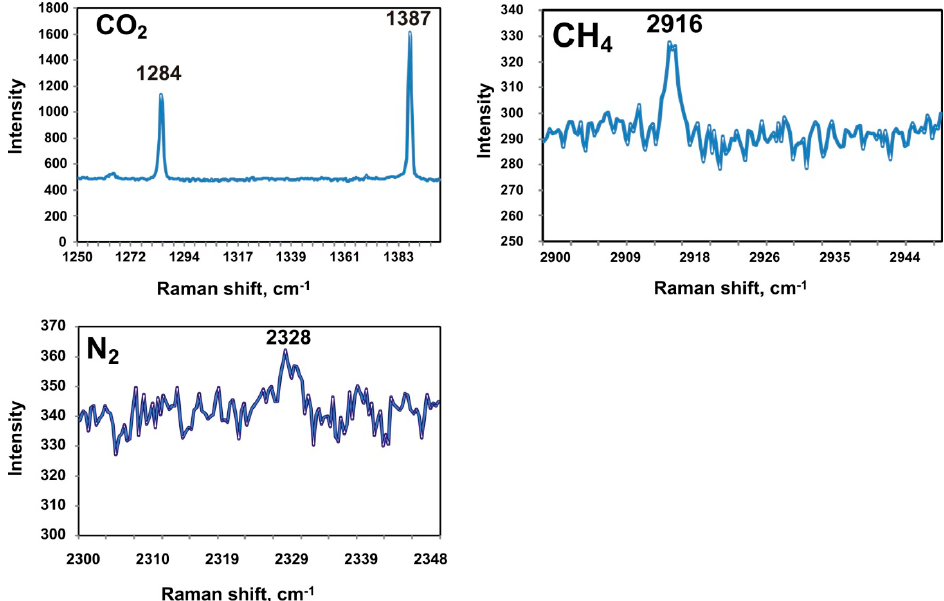
Figure 10. Results of Raman spectroscopy of individual primary fluid inclusions. Table 4. Results of the FI study in quartz from the ore veinlets of the Pervomaiskoe deposit.